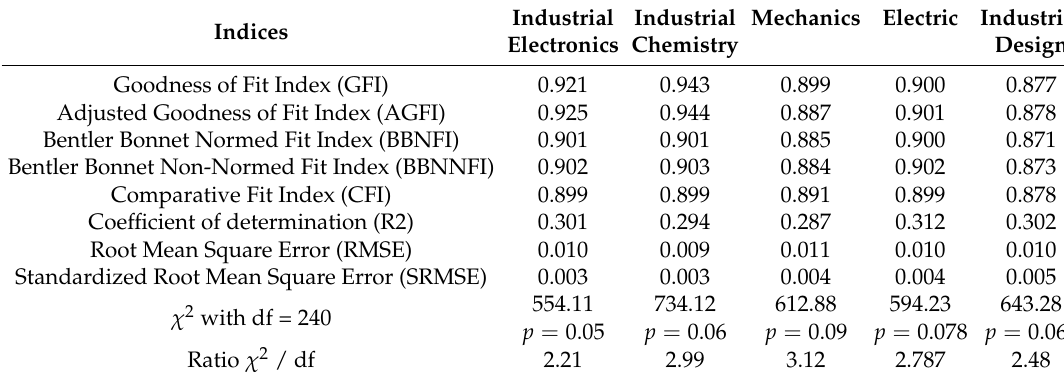
Table 5. Indices of goodness of fit for Table